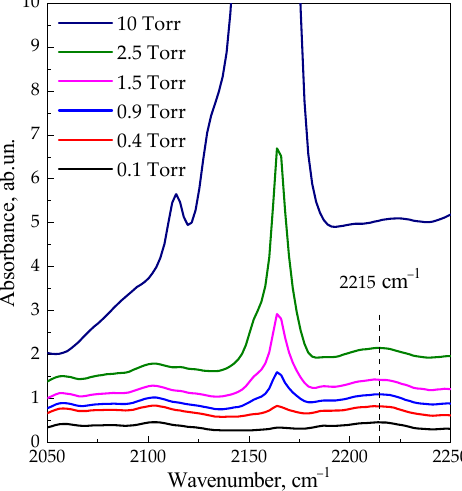
Figure 9 shows the difference spectrum obtained by subtracting the spectrum after adsorption of CO on the am- 300 sample at 77 K and p = 10 Torr (Figure 8) from the spec- trum of the am -300 sample before adsorption (Figure 6, Curve 2). It is worth noting that the intensity of bands at 3575 and 3665 cm − 1 decreases, and the broad band of H-bounded OH groups appears in the range of 3200–3800 cm − 1 with a maximum intensity at 3466 cm − 1 . According to Equation (2), the shift of 200 cm − 1 (compared to the HF band, 3665 cm − 1 ) corresponds to the strength of acid sites in the proton affinity scale of 1240 kJ/mol, which is significantly less than the shift of 250–300 cm − 1 which is characteristic for HY [97,99– 101]. This characterizes LSX zeolite in partially decationized form as a material with less strong Brønsted acidity, which corresponds to a smaller Si/Al ratio [102–106]. This value Figure 8. IR spectra of CO adsorbed on the sample am- 300 at 77 K and p ~ 0.1, 0.4, 0.9, 1.5, 2.5 and 10 torr. Figure 8. IR spectra of CO adsorbed on the sample am -300 at 77 K and p ~ 0.1, 0.4, 0.9, 1.5, 2.5 and 10 torr. is also close to the PA of the sites determined from the IR spectra of pyridine (1260 kJ/mol).